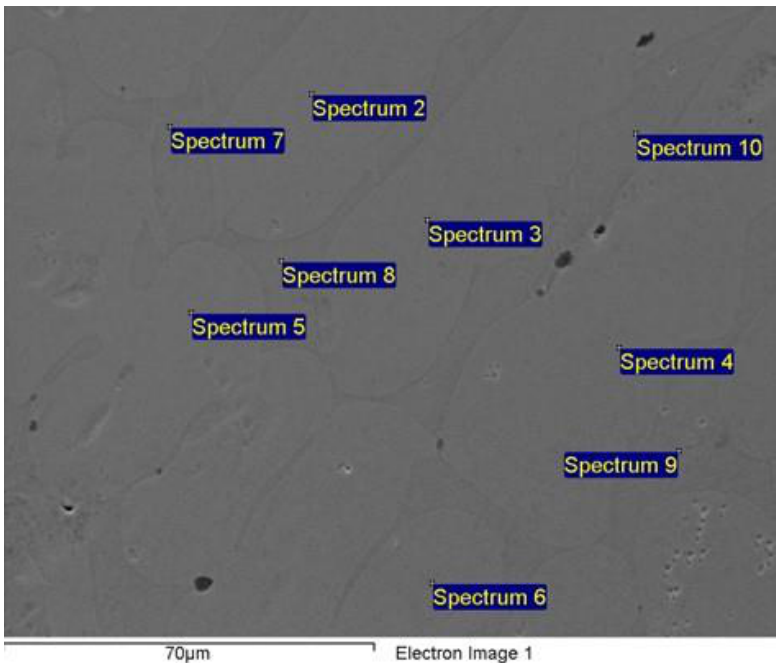
Figure 2. EDAX analysis on the surface of the alloy Al 0.6 CrFeCoNi (the point analysis of chemical composition was in the right upper corner of each rectangle). Table 2. The results in weight percentage of EDAX analysis of the alloyAl 0.6 CrFeCoNi.